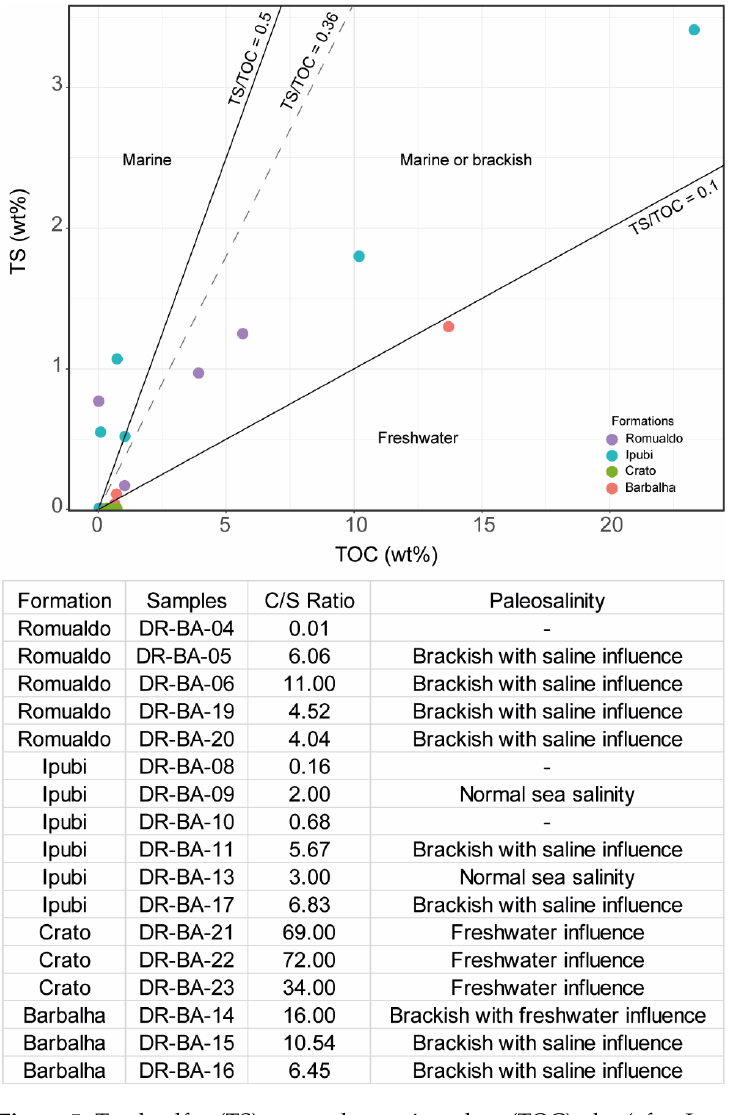
Figure 5. Total sulfur (TS) vs. total organic carbon (TOC) plot (after Leventhal, 1995 [73]) and the C/S ratio (after Woolfe et al. 1995 [75]) to interpret paleosalinity of the Santana Group. Usually, low TOC values indicate that little or no organic matter is being preserved and suggest oxic conditions [66]. In the other hand, different sub-environments in the dep- ositional systems can develop dominantly anoxic conditions when the input rate of de- gradable organic matter exceeds oxygen diffusion, so the oxygen can be depleted at the water-sediment interface of water bodies with restricted circulation. Significant anoxic events such as OAE’s (Oceanic Anoxic Events) consist of global episodes favoring organic carbon deposition and preservation [76] as a response on oceanic variations, i.e., reduced oxygenation level, sea-level rise, etc. Several models suggest even episodic causes for these events, such as restriction of paleogeographic environments relative to the oceans, stagnation of oceanic currents, increased continental surface runoff, abnormally high or- ganic productivity, and intense and widespread deep-sea volcanic activity [77]. In the con- tinental domain, anoxic conditions are more geographically restricted and may occur in